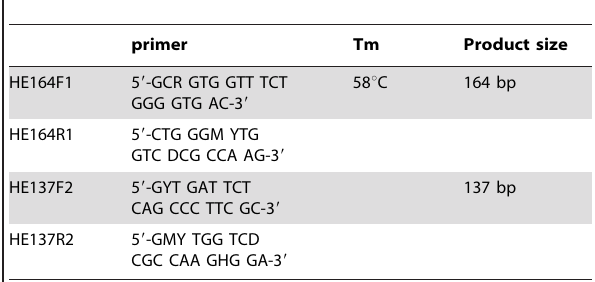
Table 1. Primers used for nested RT-PCR.